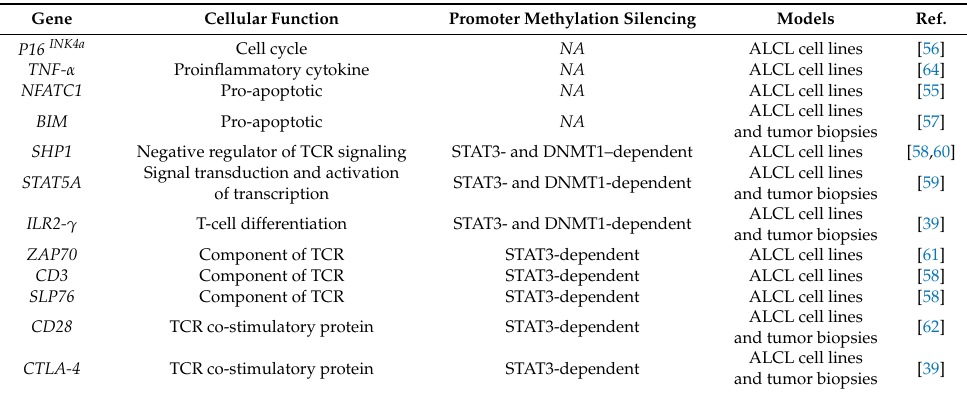
Table 3. List of coding genes silenced by DNA methylation in ALK(+)